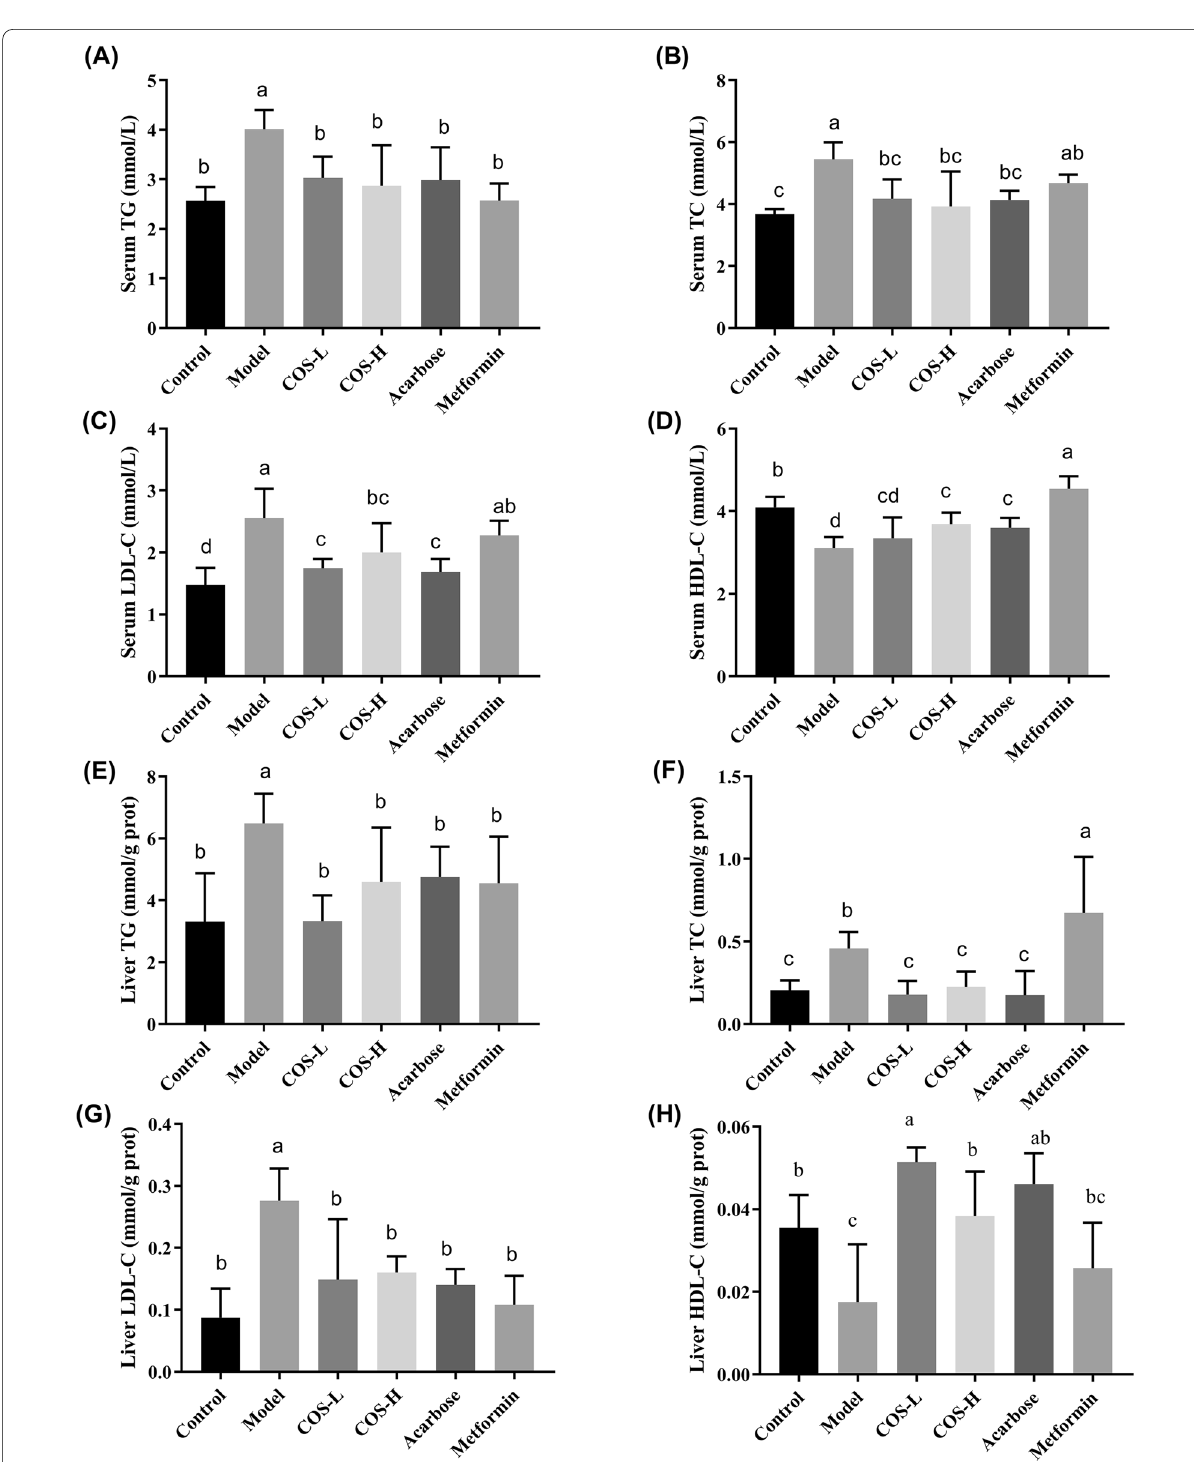
Fig. 5 The effect of COS on the biochemical serum and liver indexes of the mice. A TG level in the serum. B TC level in the serum. C LDL-C level in the serum. D HDL-C level in the serum. E TG level in the liver. F TC level in the liver. G LDL-C level in the liver. H HDL-C level in the